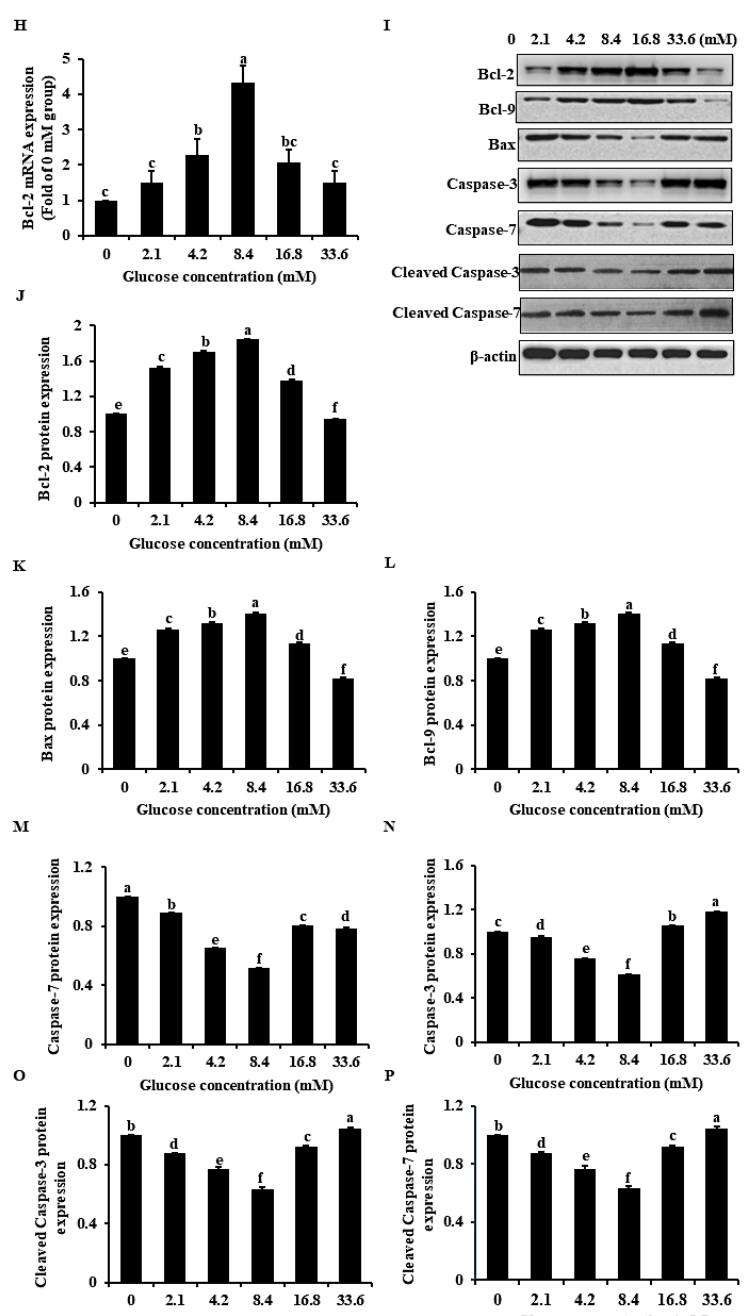
Figure 1. Basic characteristics of granulosa cell (GC) models in different glucose (0 mM, 2.1 mM, 4.2 mM, 8.4 mM, 16.8 mM, and 33.6 mM) groups. ( A ) Analysis of apoptosis level of GC receiving differing solutions of glucose followed by Annexin V-FITC/PIkit and flow cytometry. ( B ) Apoptosis rate of granulosa cells in different glucose concentration groups. ( C ) CCK-8 assay was performed to assess the effect of glucose on granulosa cells proliferation. ( D – H ) The doses of glucose affected mRNA expression of bax , caspase-3 , caspase-7 , Bcl-9 and Bcl-2 , which are linked to regulation of apoptosis. ( I ) The doses of glucose affected protein expression of Bcl-9, Bcl-2, bax, caspase-3 and caspase-7, which are linked to regulation of apoptosis. ( J – P ) The levels of Bcl-9, Bcl-2, bax, caspase-3, caspase-7, cleaved caspase-3 and cleaved caspase-7 induced by glucose were measured by western blot in GCs. Protein levels were quantified by ImageJ software and normalized to the loading controls. n = 3 in each group; the different lowercase letters indicate significant differences ( p <